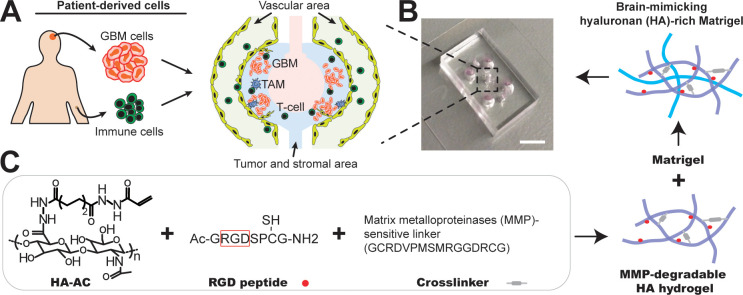
Microfabrication of the microfluidics-based ‘GBM-on-a-Chip’ microphysiological system.(A) A schematic illustrating the layout of ex vivo microphysiological system populated by using patient-resected tumor cells and human primary immune cells. The system consists of peripheral regions (yellow) for brain vascular growth, and immune cell seeding, middle regions (blue) for tumor and stromal TAMs growth, and center region (pink) for cell culture medium infusion. (B) A photo showing the actual microfluidic chip. Scale bar is 5 mm. (C) A schematic demonstrating the synthesis of brain-mimicking HA-rich Matrigel ECM. RGD peptides are conjugated onto Acrylated hyaluronic acid (HA-AC) and crosslinked with MMP-degradable crosslinker (GCRDVPMSMRGGDRCG). To further mimic the tumor microenvironment growth-factor-reduced Matrigel matrix is interpenetrated with MMP-degradable HA hydrogel for brain tissue-mimicking ECM.